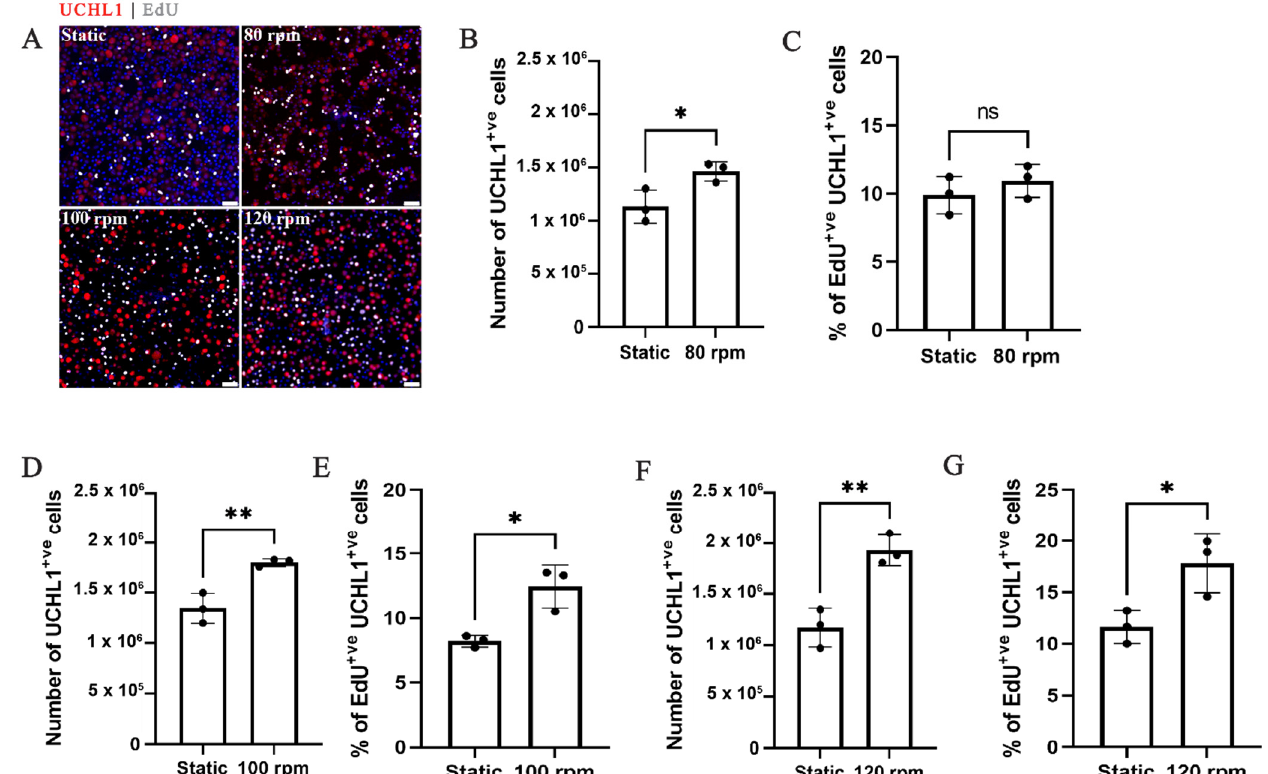
Figure 1. Stirred suspension bioreactor culture at 120 rpm (3.9 dyne/cm 2 ) supports the highest level of spermatogonia proliferation: ( A ) immunofluorescence images of spermatogonia after static, 80, 100, and 120 rpm SSB culture. Scale bars 50 µ m; ( B , D , F ) number of spermatogonia harvested after 2 weeks of SSB and static culture at 80 ( B ) 100 ( D ), and 120 ( F ) rpm; ( C , E , G ) percentage of proliferating spermatogonia after 2 weeks of SSB and static culture 80 ( C ), 100 ( E ), and 120 ( G ) rpm. n = 3, mean ± SD. p > 0.05 (ns), * p ≤ 0.05, ** p ≤ 0.01.